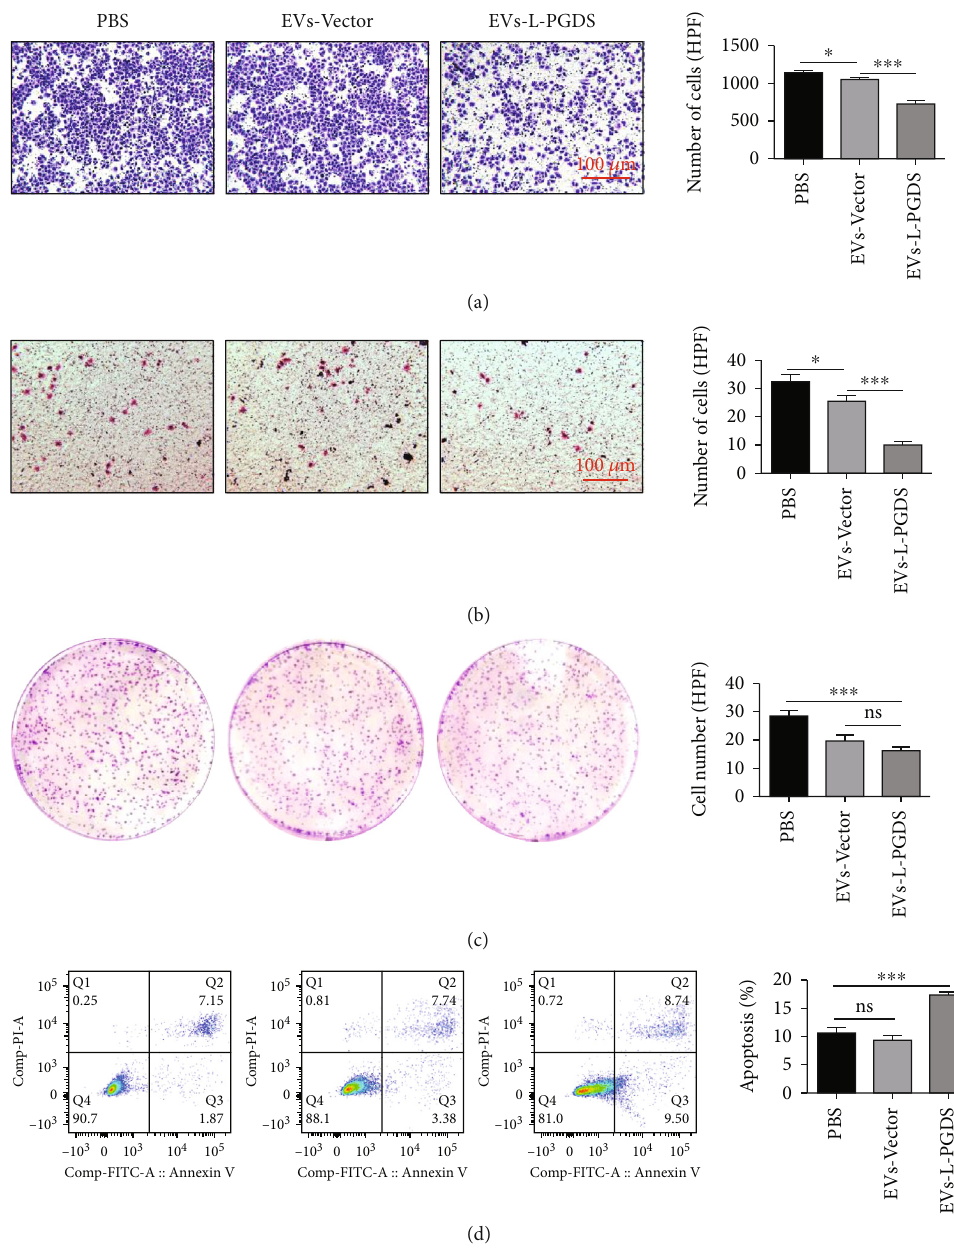
Figure 4: EVs-L-PGDS inhibited migration, invasion, and colony formation and induced apoptosis of gastric cancer cell SGC-7901. (a) Transwell migration experiments for the migration ability of SGC-7901 cells ( × 100). (b) Transwell invasion experiments for the invasion ability of SGC-7901 cells ( × 100). (c) Colony-forming assay for the colony formation ability of SGC-7901 cells. (d) Flow cytometry assay for the apoptosis level of SGC-7901 cells. n = 6 ; ∗ P < 0 : 05 , ∗∗ P < 0 : 01 , and ∗∗∗ P < 0 : 001 . Abbreviations: HPF: high-power fi